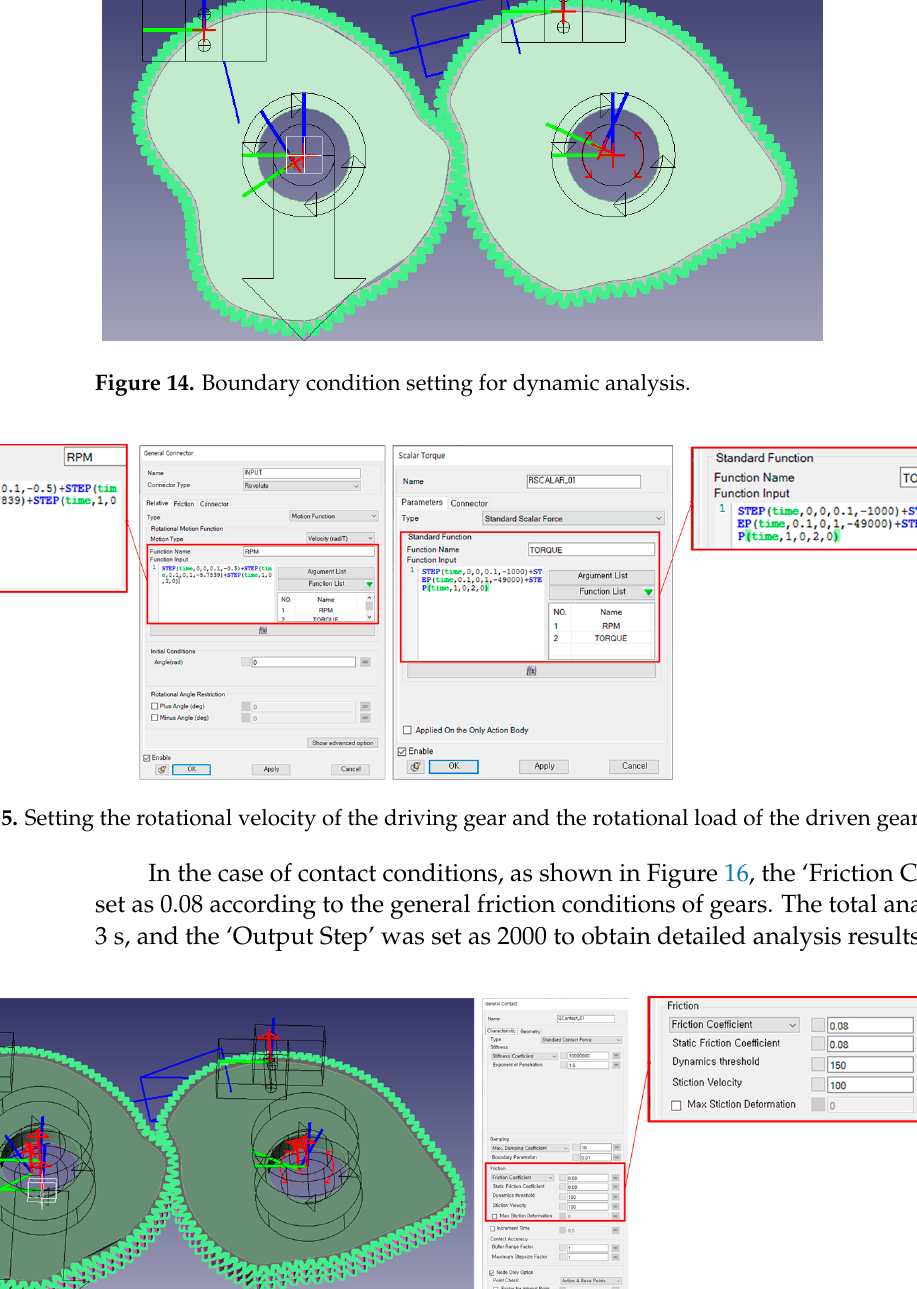
Figure 16. Contact condition setting for non-circular gears.